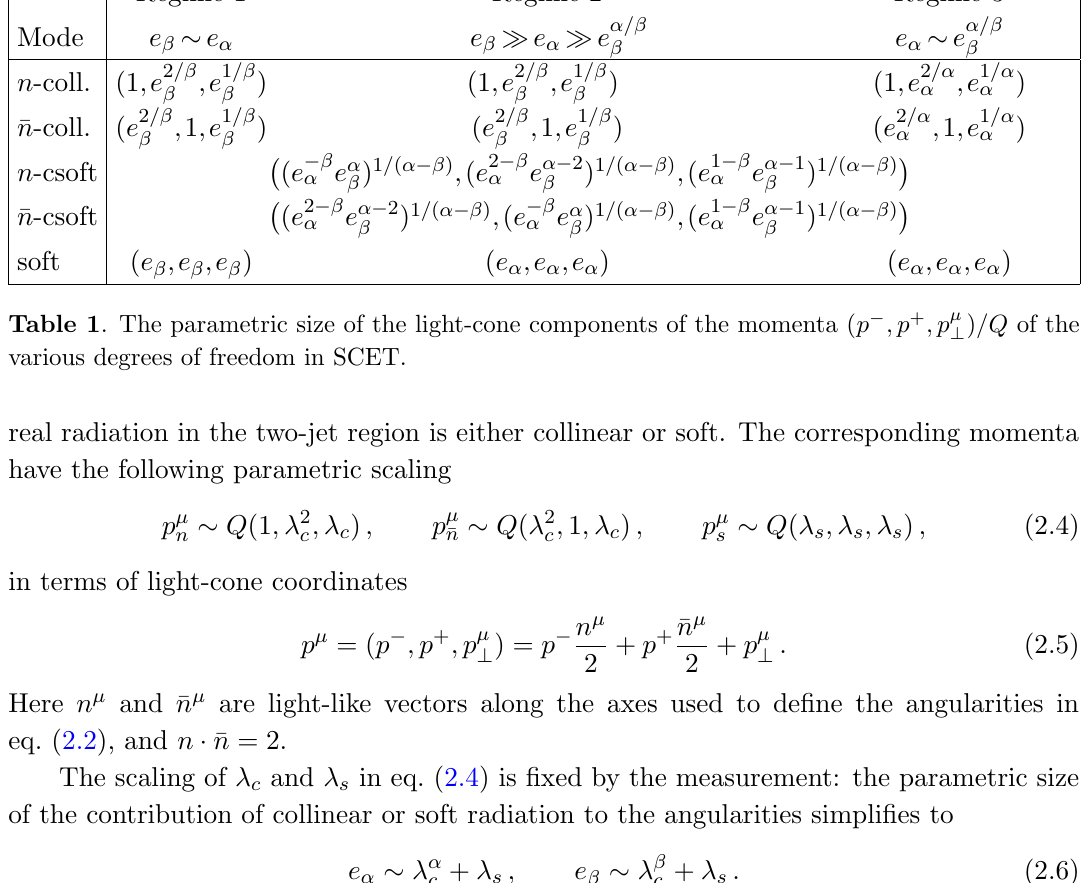
Figure 1 . The phase space for the simultaneous measurement of e of Soft-Collinear E(cid:11)ective Theory.